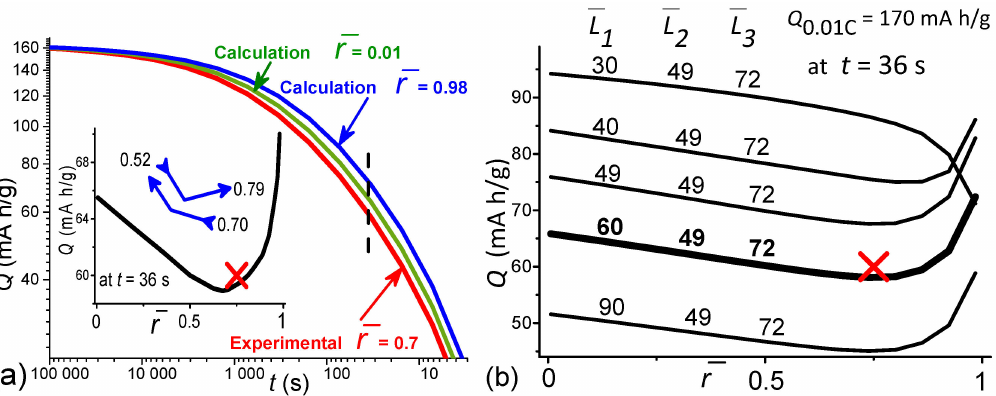
Figure 10. ( a ) Q ( t ) dependences on the mean values of the correlation coefficients r In the inset, Q ( t ) dependence on r at t = 36 s (marked by a vertical dotted line); the red cross marks the sample N1 r value. A scheme of r changes during measurements from small to large t is shown. ( b ) Q ( t ) dependences on r normalized to Q 0.01 at t = 36 s for the indicated average crystallite sizes; the thick curve and the red cross are for N1